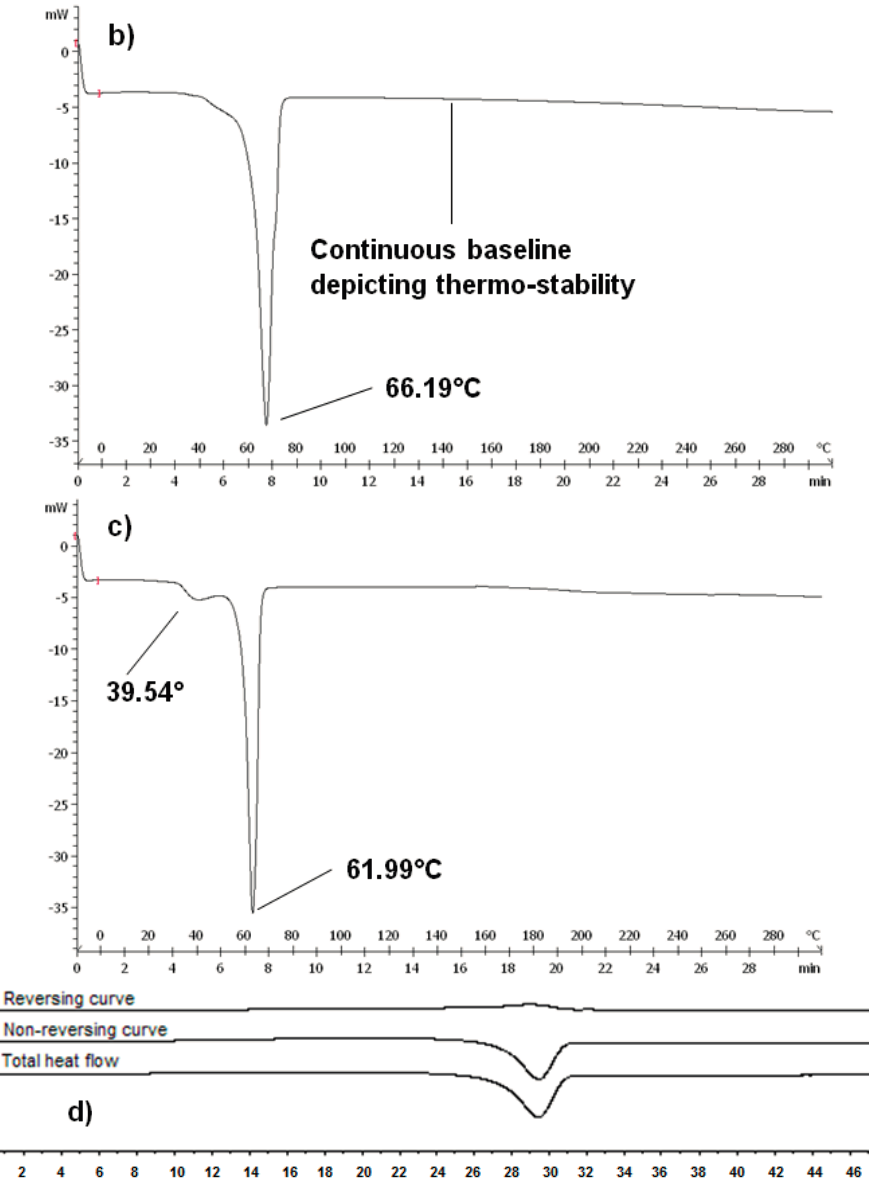
Figure 4. DSC of ( a ) CPZ ( b ) PCL and ( c ) CPZ-loaded PCL based nanocapsule